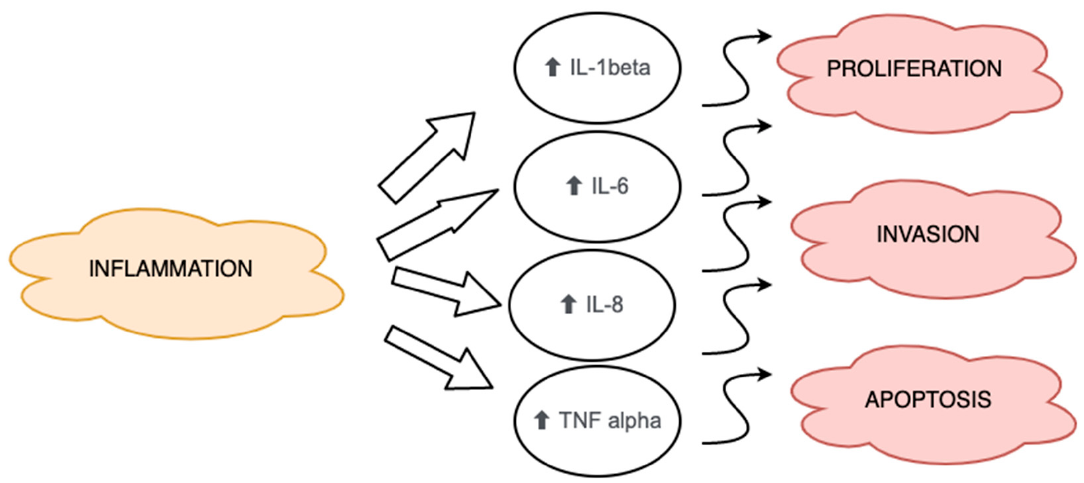
Figure 2. Changes in interleukin and TNF α levels due to chronic inflammation caused by obesity.